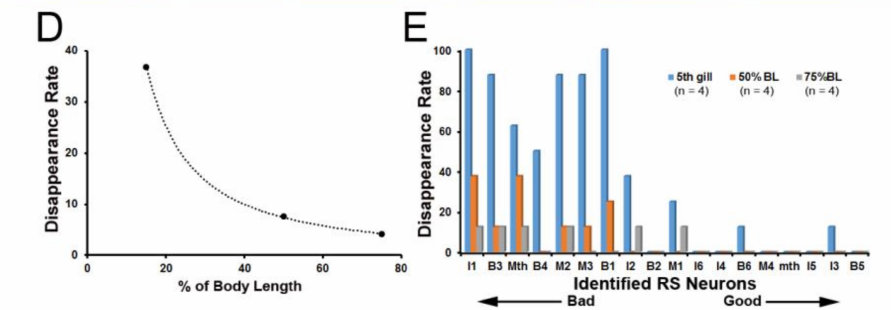
Figure 6. Distance-dependence of retrograde neuronal death. Neuronal death was demonstrated by disappearance of giant RS neurons in Nissl-stained brain whole-mounts 24 weeks post-TX. ( A ) Spinal cord TX at the 5th gill (20% BL) led to the disappearance of many identified RS neurons (white arrows); ( B ) TX at 50% BL, showed fewer lost RS neurons (white arrows); ( C ) most RS neurons survived when TX was at the level of the cloaca (75% BL); ( D ) the probability of death is shown for the identified RS neurons after TX at each level; ( E ) the probability of cell death decreases with the regenerative ability and distance of TX from the perikaryon.